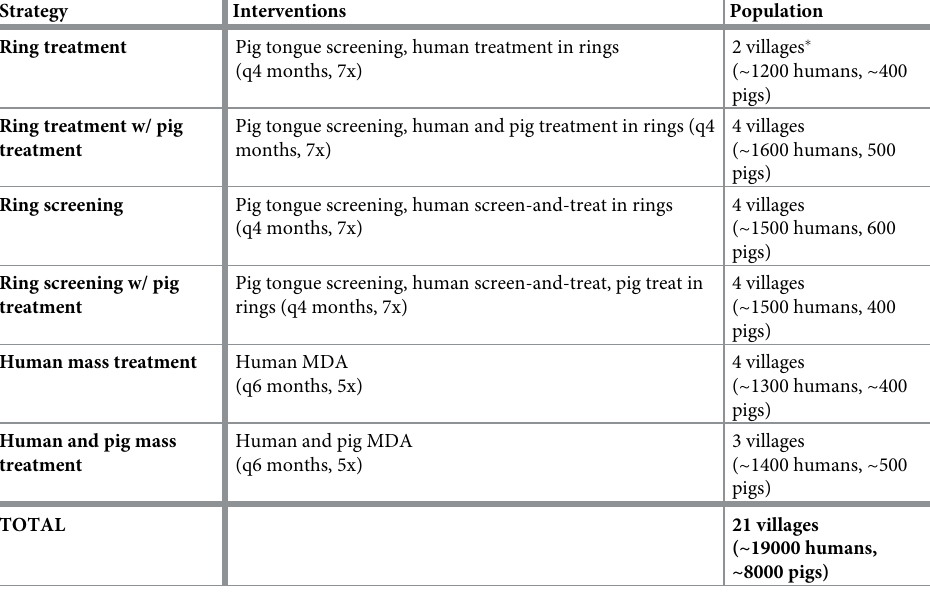
Table 2. Summary of interventions and populations in Ring Strategy Trial–Peru,